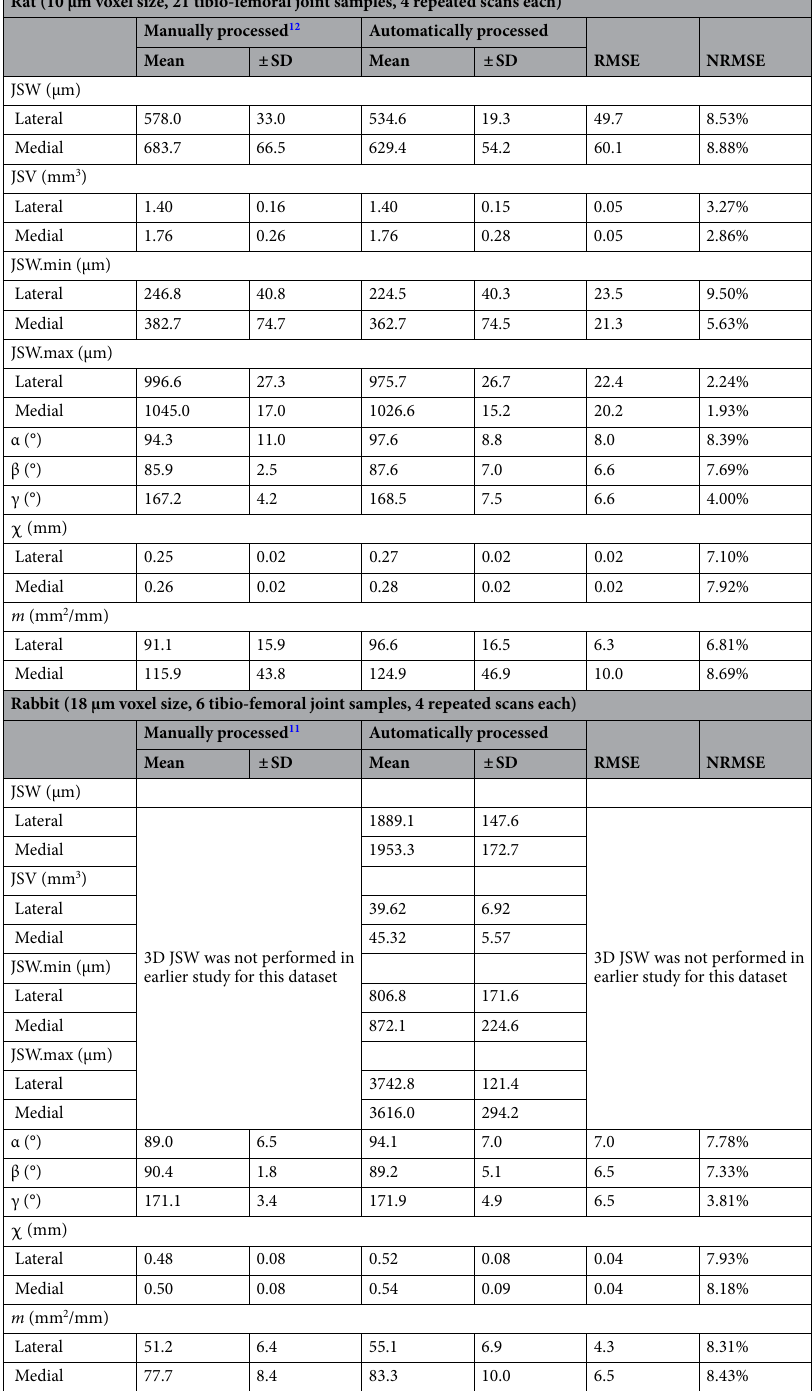
Table 4. 3D joint QMA results for rat and rabbit datasets obtained in previous studies through manual processing, and in this study using the proposed automatic workflow. Accuracy of the automatically processed rat and rabbit measurements are shown in terms of root-mean-squared error expressed in absolute (RMSE) and mean-normalised (NRMSE) form (JSW: mean joint space width, JSV: joint space volume, JSW.min: minimum joint space width, JSW.max: maximum joint space width, α: angle with respect to x-axis, β: angle with respect to y-axis, γ: angle with respect to z-axis, χ : distance travelled to first contact, m : rate at which contact area